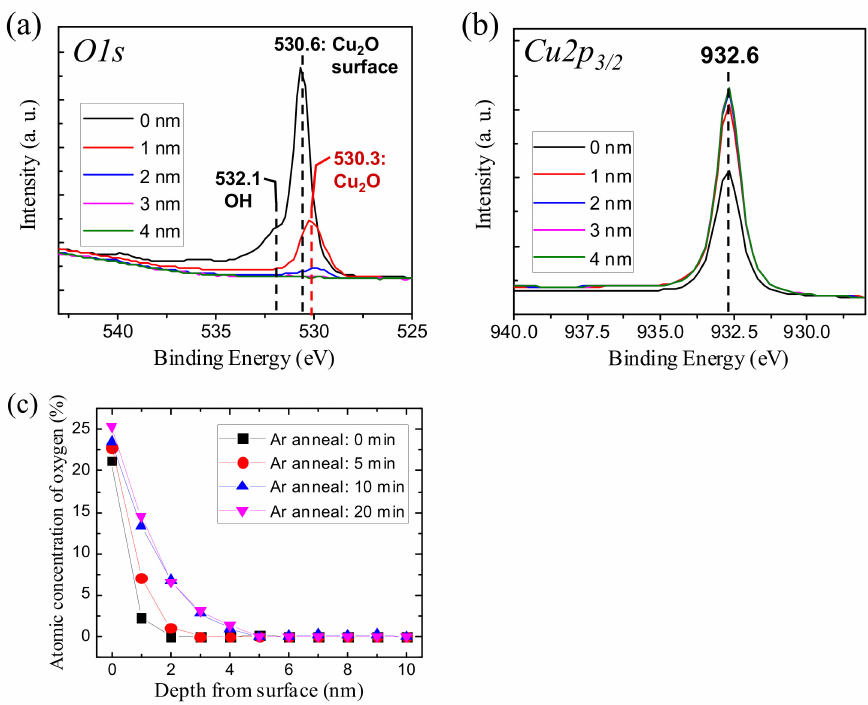
Figure 3. XPS analysis of annealed Cu foils without growth of graphene. ( a , b ) High-resolution O1 s and Cu2 p 3/2 XPS depth profiling of Cu foils with Ar annealing for 5 min; ( c ) Dependence of oxygen concentration on depth from surface of Cu foils with different Ar annealing